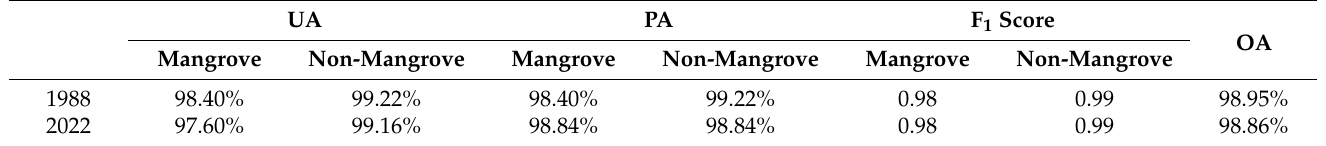
Table 2. Accuracies of mangrove maps in 1988 and